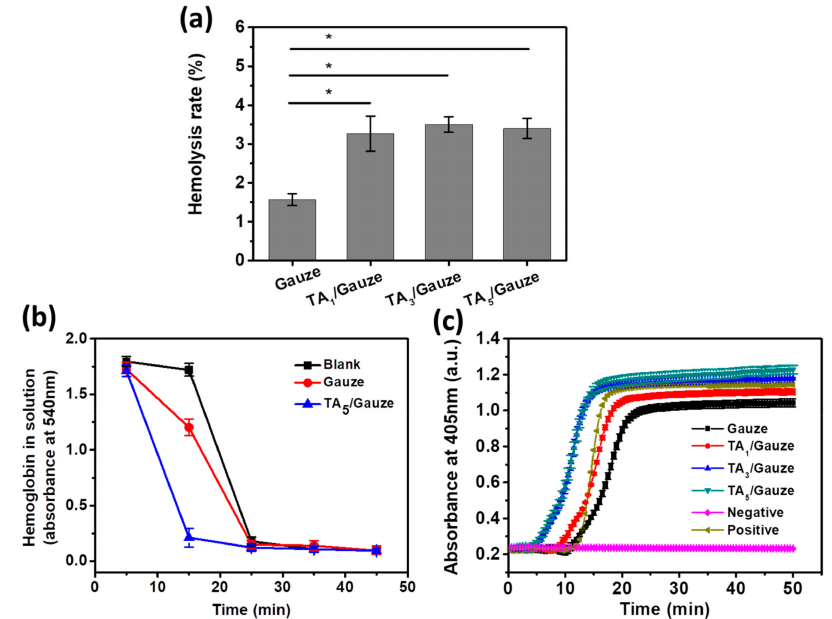
Figure 5. Hemostasis performance of the TA-coated gauze. ( a ) Hemolysis rate of gauze and TA-coated gauze. Mean ± SD. Statistical analysis was performed with a one-way ANOVA test, *: p < 0.05; ( b ) Released hemoglobin concentration after incubation of the gauze or TA-coated gauze with blood. “Blank” is the blood clotted with nothing added; ( c ) Plasma recalcification profiles (PRT) of gauze and TA-coated gauze. Negative contrast is the blood clotted without CaCl 2 solution added; Positive contrast is the blood clotted with the addition of CaCl 2